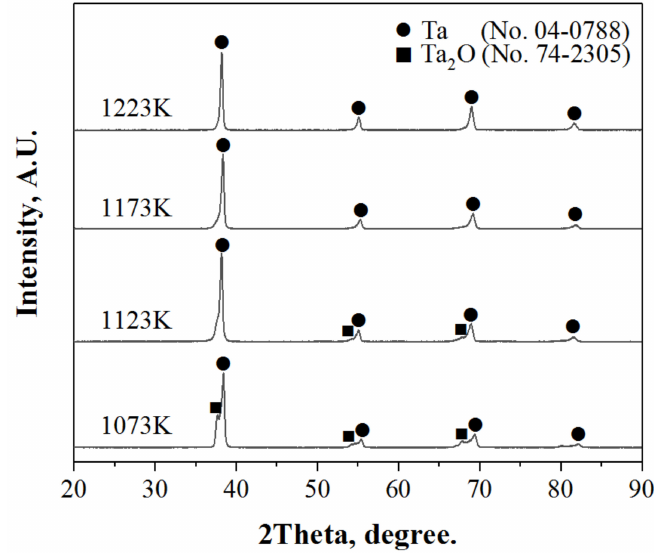
Figure 10. X-ray diffraction patterns measured in Mg-reduced samples at various reduction